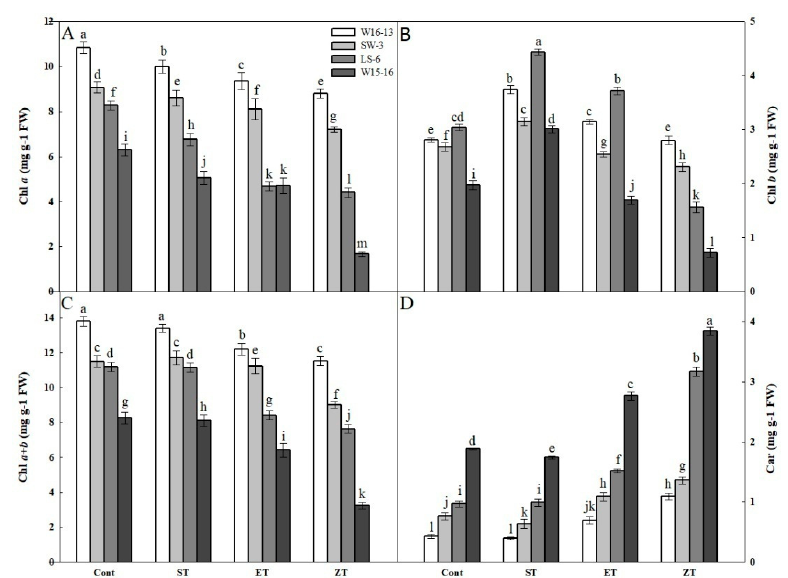
Figure 9. Effects of cold stress on ( A ) Chl a , ( B ) Chl b , ( C ) Chl a+b , ( D ) Car in four wucai genotypes. Values represent the mean SE ( n = 3). Values with the same letter are not significantly different at the p < 0.05. Cont: 25/18 °C (d/n); ST: 16/10 °C (d/n); ET: 8/2 °C (d/n); ZT: 0/ − 6 °C (d/n).